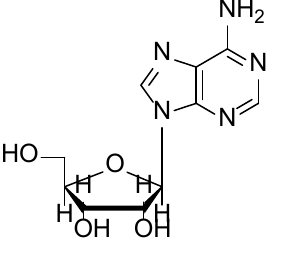
Figure 2 : Structure of adenosine.